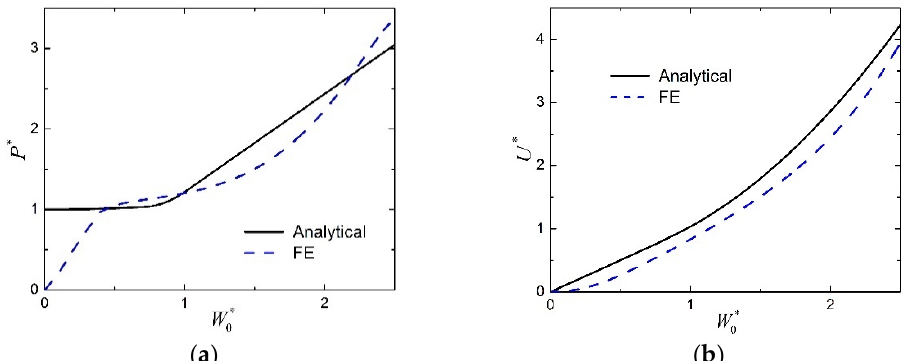
Figure 6. Comparison between analytical predictions and numerical results for the large deflection response of FML sandwich beams under transverse loading (Case 2): ( a ) Load versus midspan deflection; ( b ) absorbed energy versus midspan deflection.